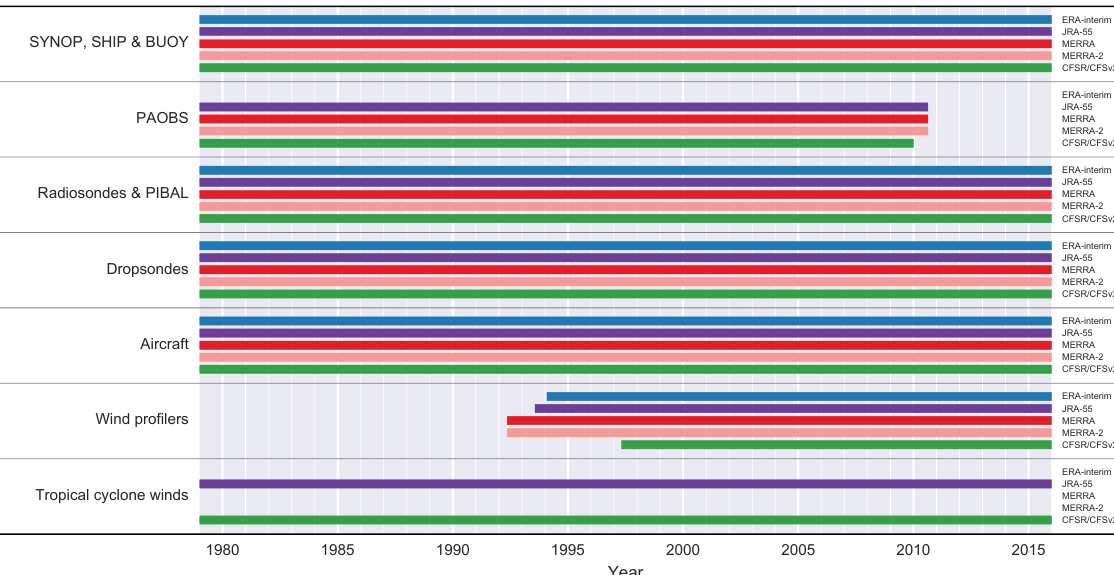
Figure 6. Timelines of conventional observations assimilated by the ERA-Interim (blue), JRA-55 (purple), MERRA (dark red), MERRA-2 (light red), and CFSR (green) reanalysis systems. See Appendix A for abbreviation definitions.